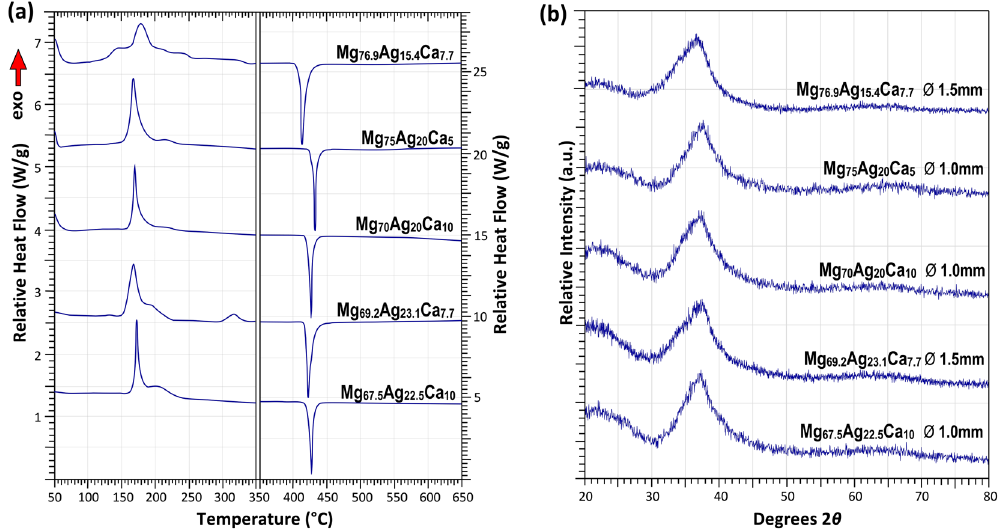
Figure 2. Selected ( a ) DSC and ( b ) XRD traces of Mg–Ag–Ca